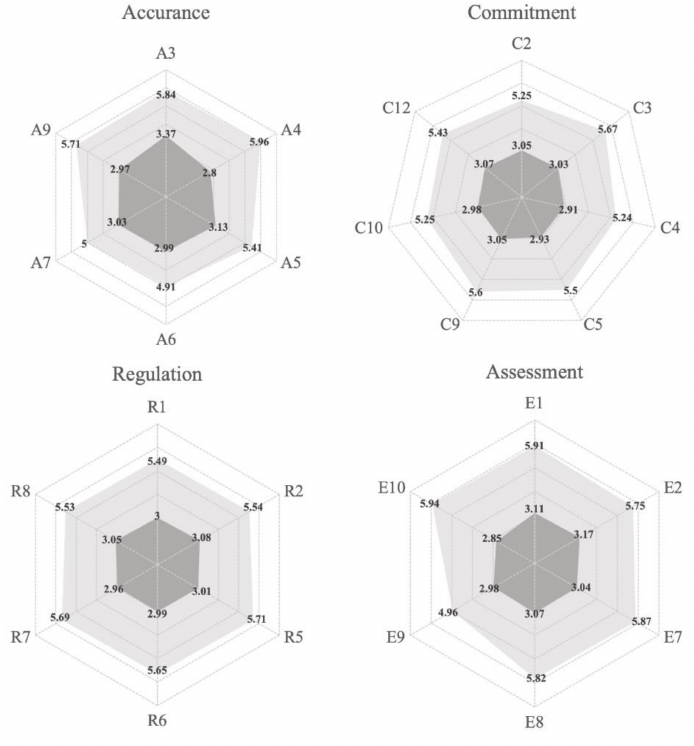
Figure 3. Food safety gaps of all